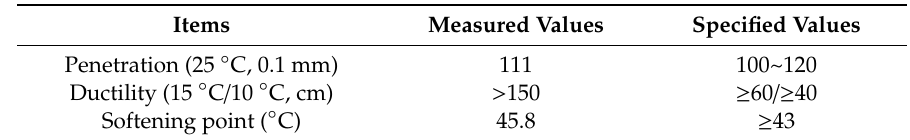
Table 1. Matrix bitumen properties.